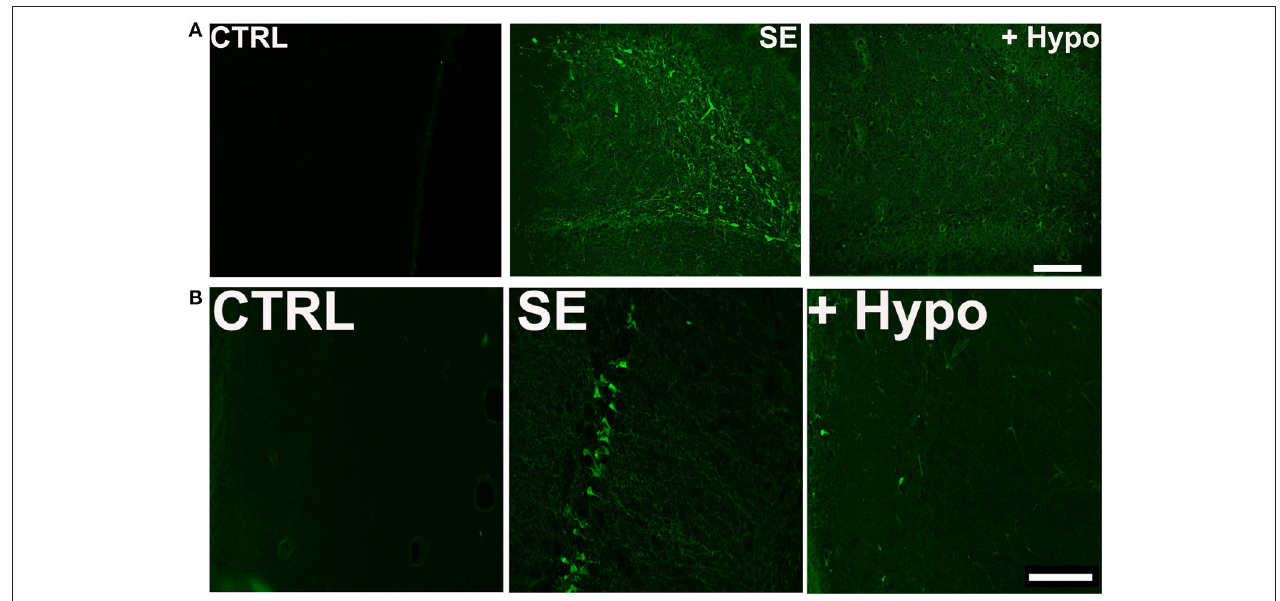
FIGURE 4 | Neuroprotective effect of hypothermia. Representative photomicrographs of Fluoro-Jade C (FJC) staining in the (A) dentate gyrus hilus and (B) CA1 region of a control (CTRL), pilocarpine-SE (SE), and hypothermia ( + HYPO) treated rats. Scale bars, 100 µ m.